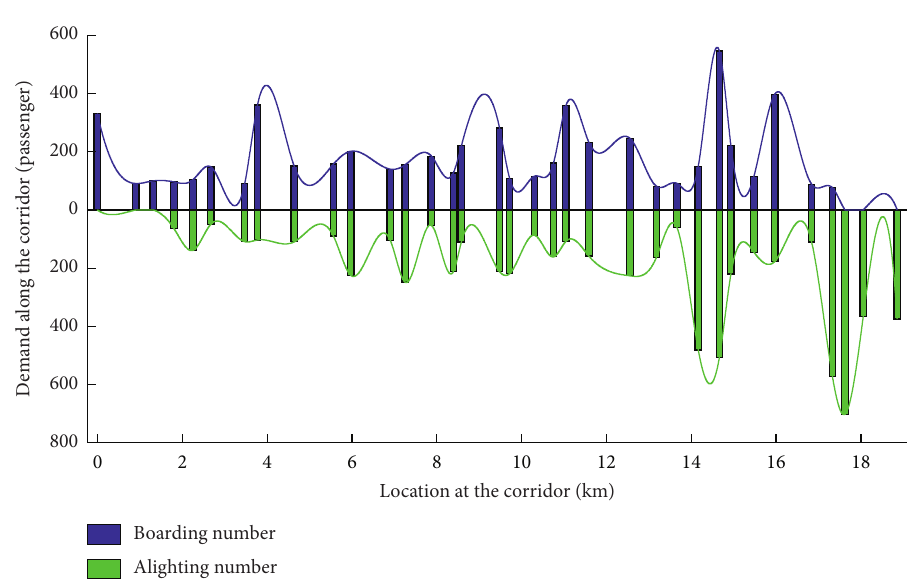
Figure 4: Boarding and alighting demand along the bus route (the peak period, for